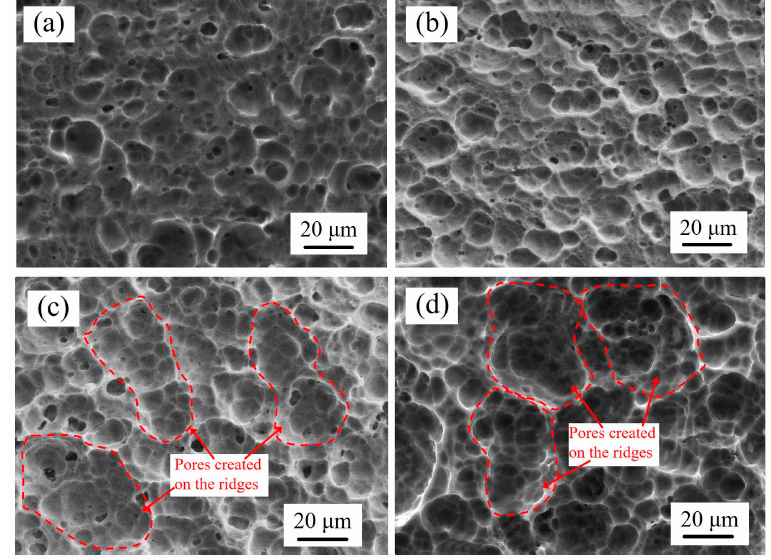
Figure 7. Substrates treated with combined methods: ( a ) process 1, ( b ) process 2, ( c ) process 3, and ( d ) process 4.